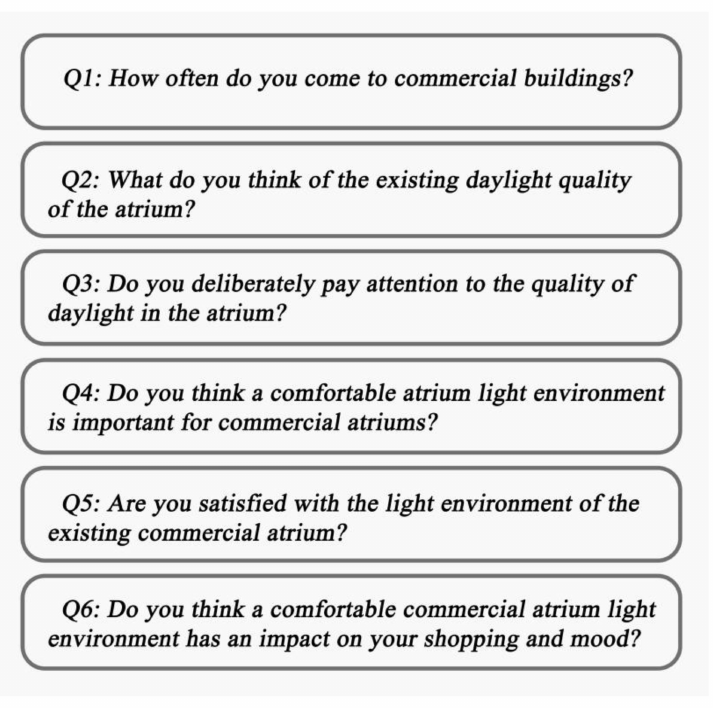
Figure 6. Questionnaire